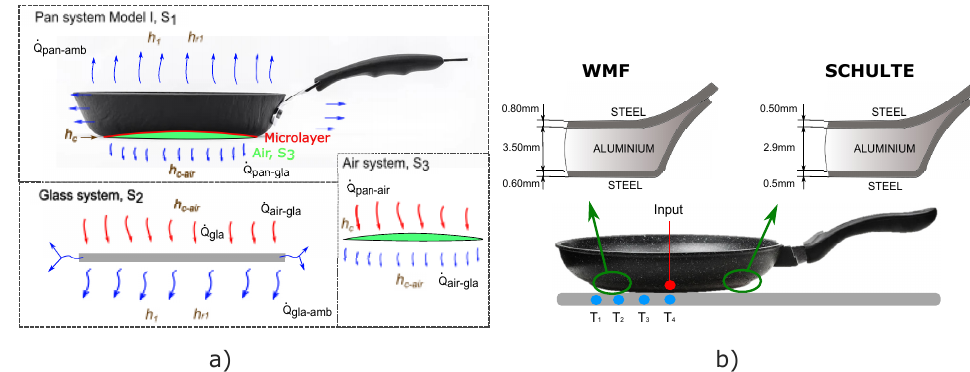
Figure 1. ( a ) Representation of the systems that form Model I ( S 1 and S 2 are the same for Model II). S 1 corresponds to the system of the solid/pan, S 2 corresponds to the glass and S 3 corresponds to the air. The input heat is shown as red arrows, while outgoing heat is shown by blue arrows. ˙ Q pan − air and ˙ Q air − glass corresponds only to Model I. ( b ) Distribution of thermocouples in the vessel and the glass. The thermocouple (red) placed at the centre is used as input for the PI control ( T sensor ). Blue thermocouples are placed below the